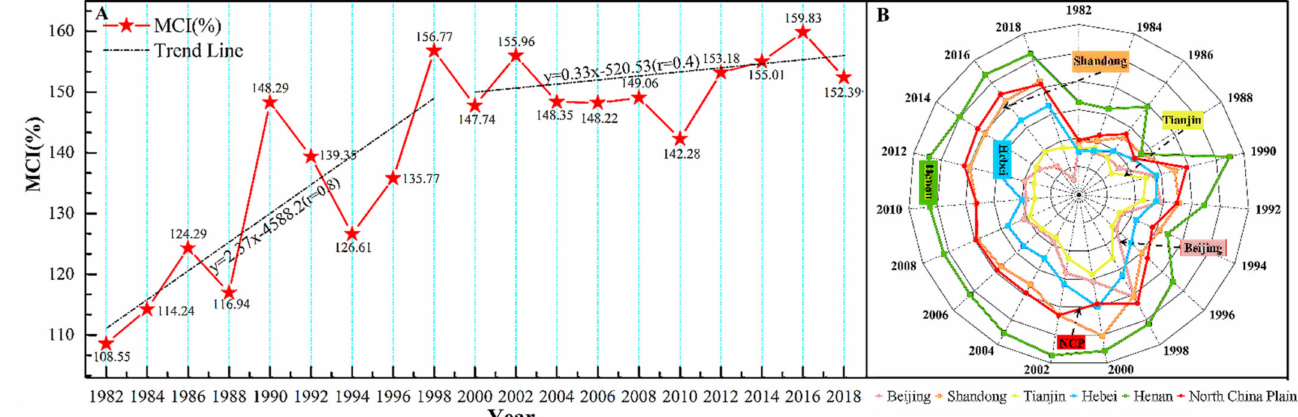
Figure 10. Interannual variation in the CI of cultivated land on the NCP and the five provinces and cities in the study area from 1982 to 2018. ( A ) Interannual variation in the CI of cultivated land from 1982 to 2018; ( B ) radar map of the interannual variation for the five provinces and cities.